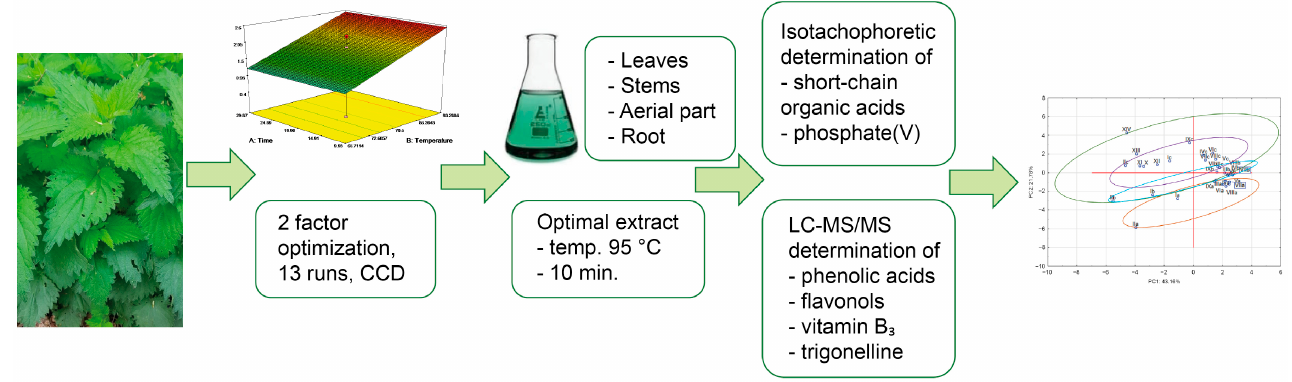
Figure 3. Workflow diagram.